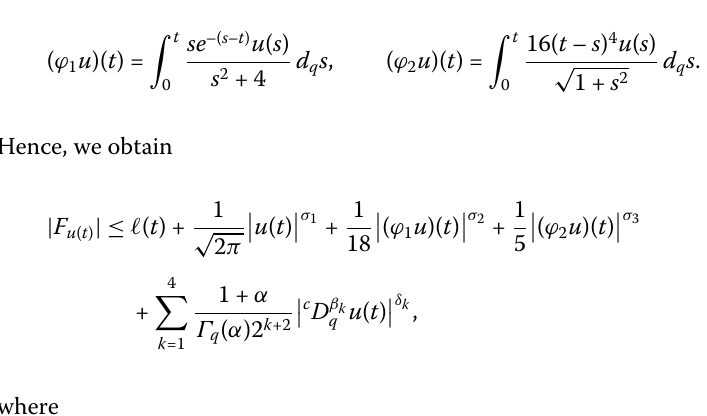
Table 3 Some numerical results for calculation of (cid:13) with q = 4